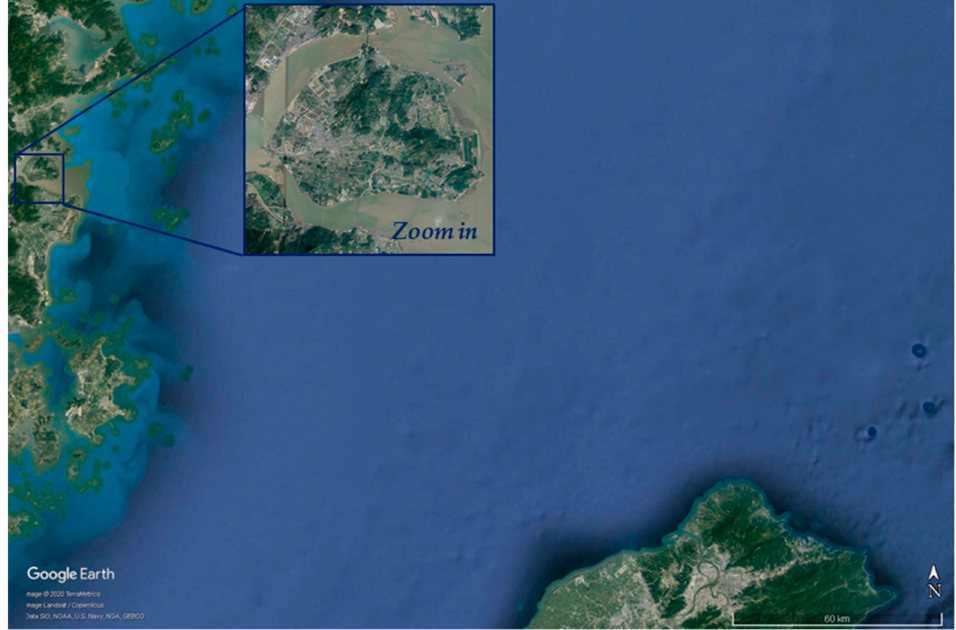
Figure 7. A Google Earth image corresponding to the coverage areas of 11.jpg in Taiwan Strait. In the Google Earth software, more image details can be obtained by the operation of zooming in.